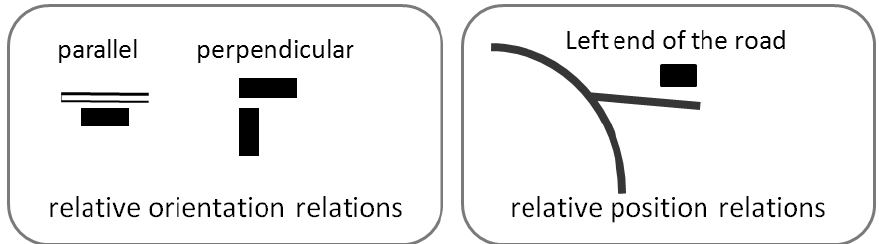
Figure 11. Examples of relative orientation and position relations to preserve during conflation.